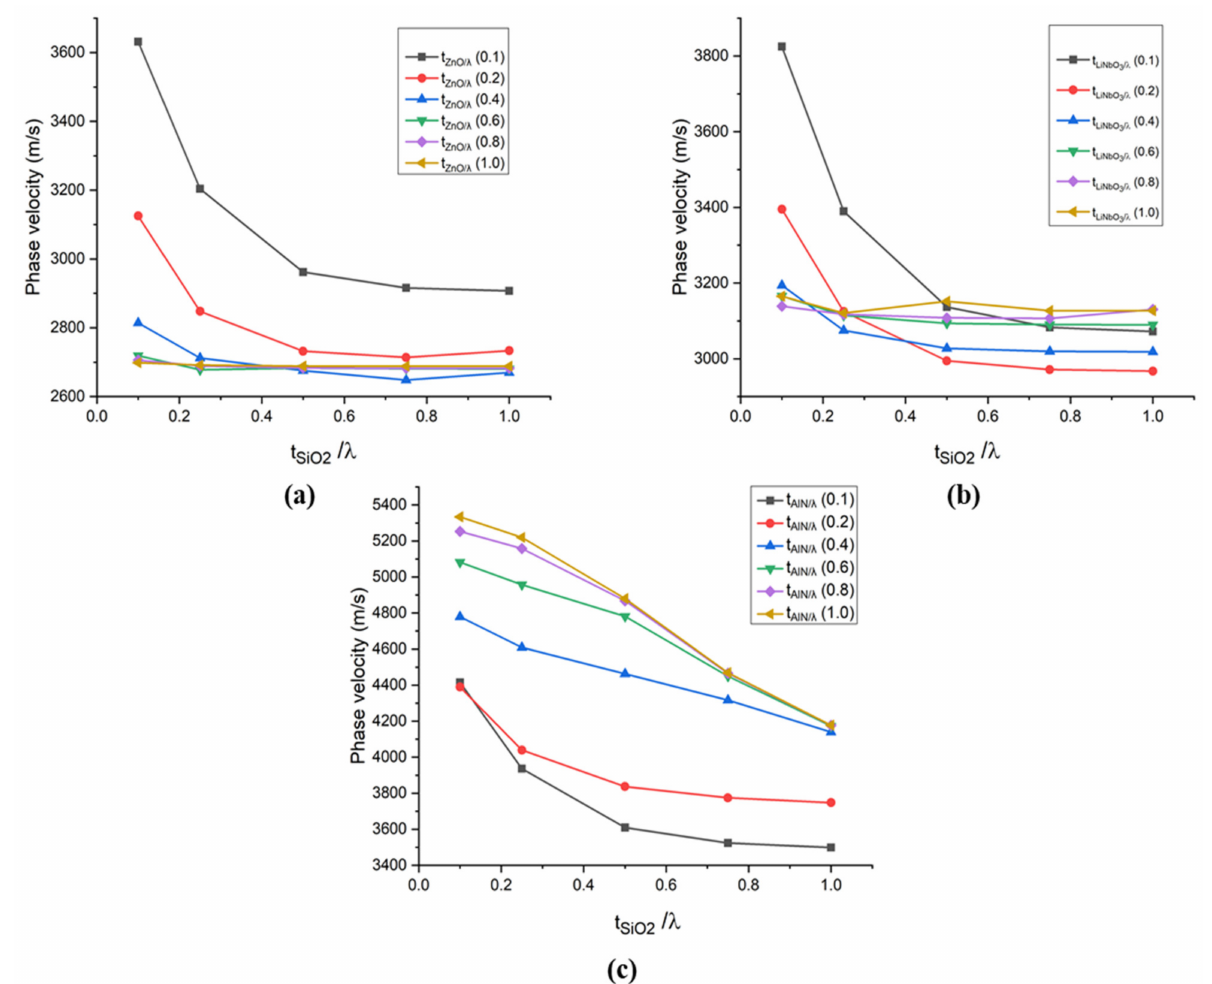
Figure 7. Phase velocity versus normalised thickness of SiO 2 on different normalised thicknesses of ( a ) ZnO ( b ) LiNbO 3 ( c )